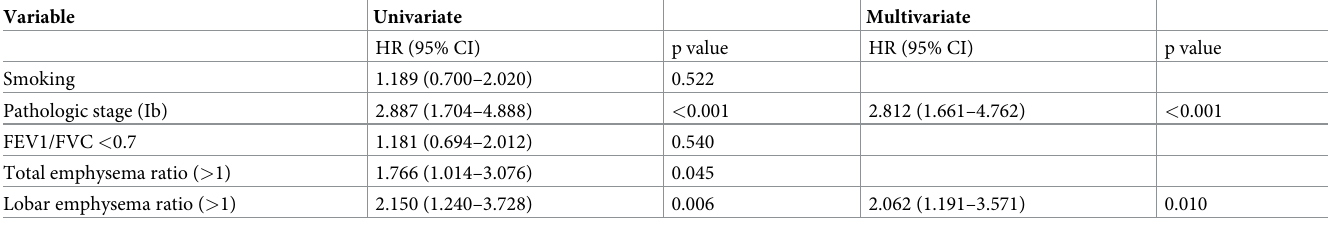
Table 3. Univariate and multivariate analysis of significant predictors for the disease-free survival in patients with stage I NSCLC.